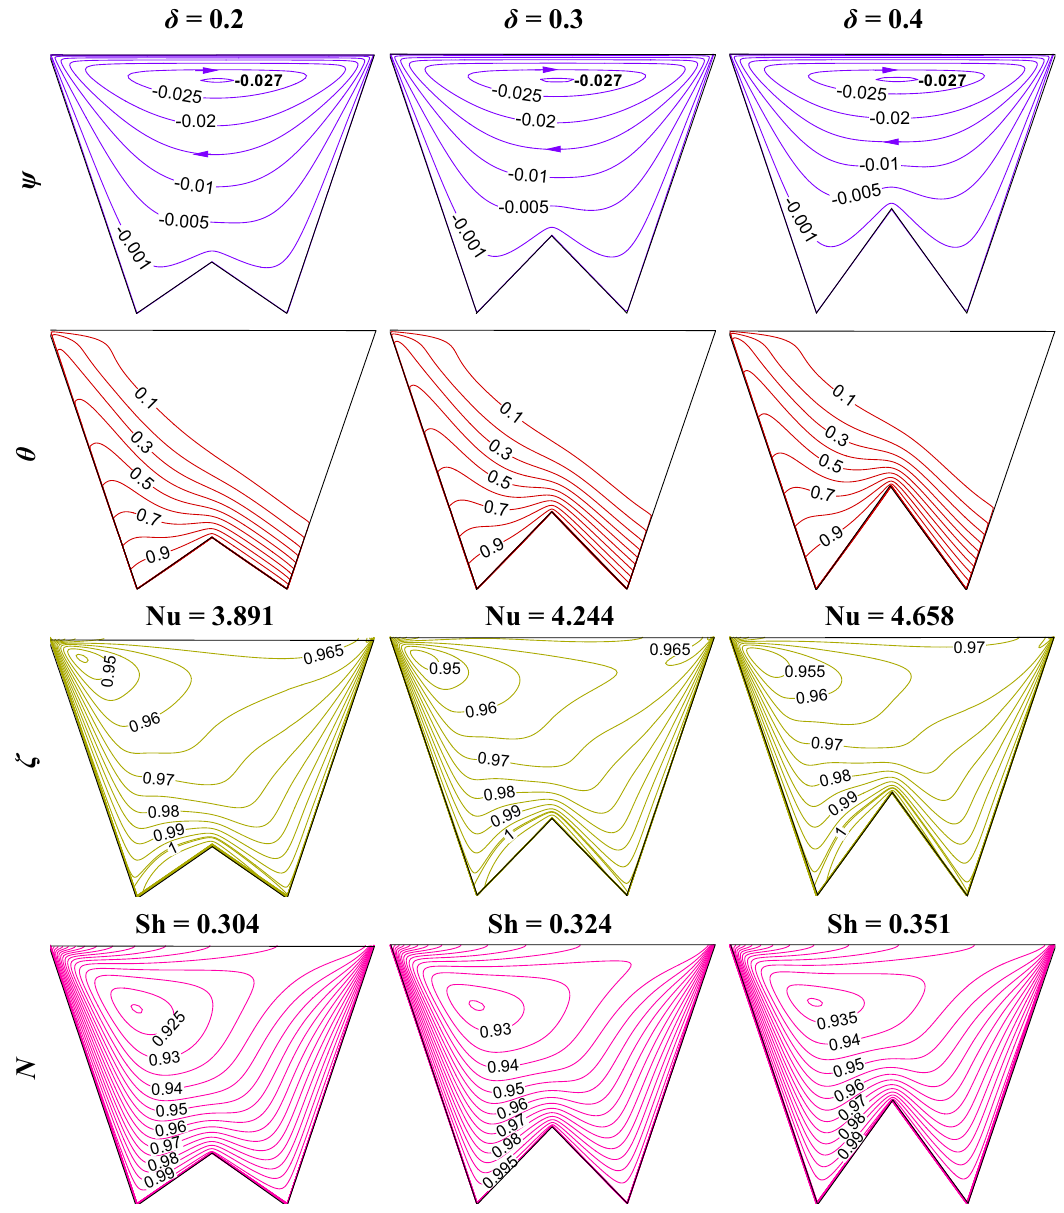
Figure 9. Streamline contours ( ψ ), Isotherms contours ( θ ), Oxygen isoconcentration ( ζ ), Microorganisms isoconcentration ( N ) for different triangular bottom heights ( δ ) at R b = 50, Le = Pe = 1, Gr = 10 3 , Da = 10 –3 , Ha = 30, m = 1, and γ =